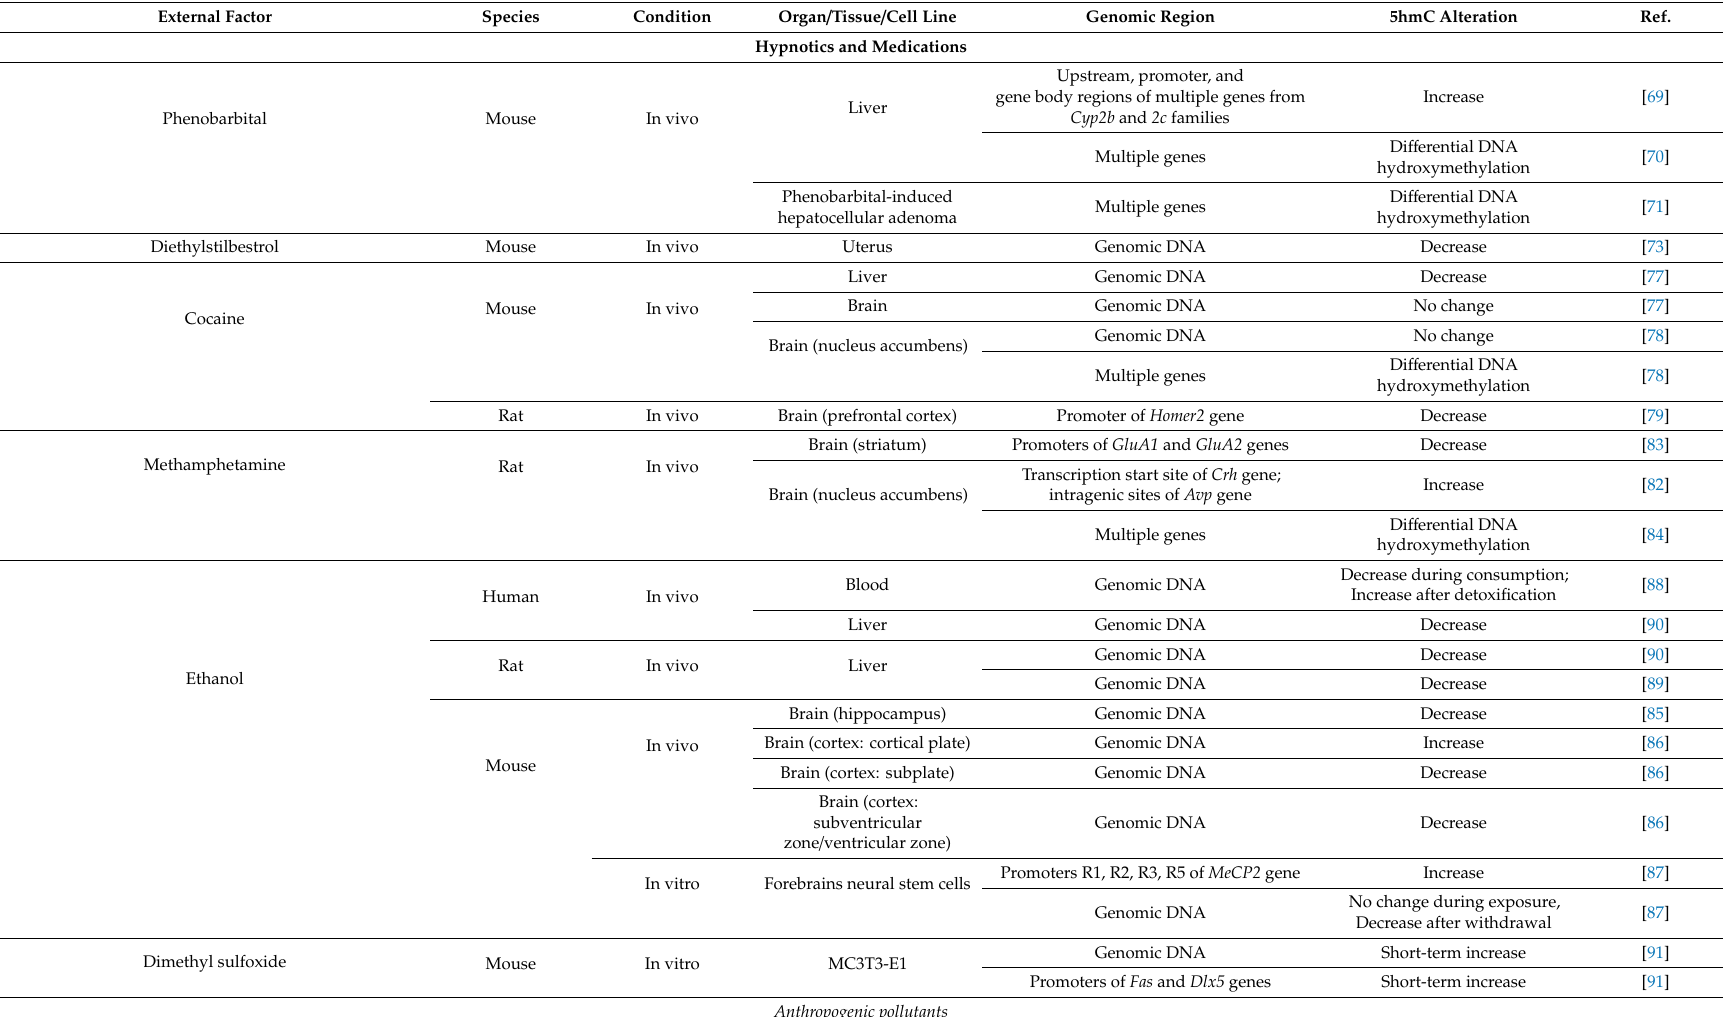
Table 1. 5-hydroxymethylcytosine changes in mammalian genome upon exposure to external